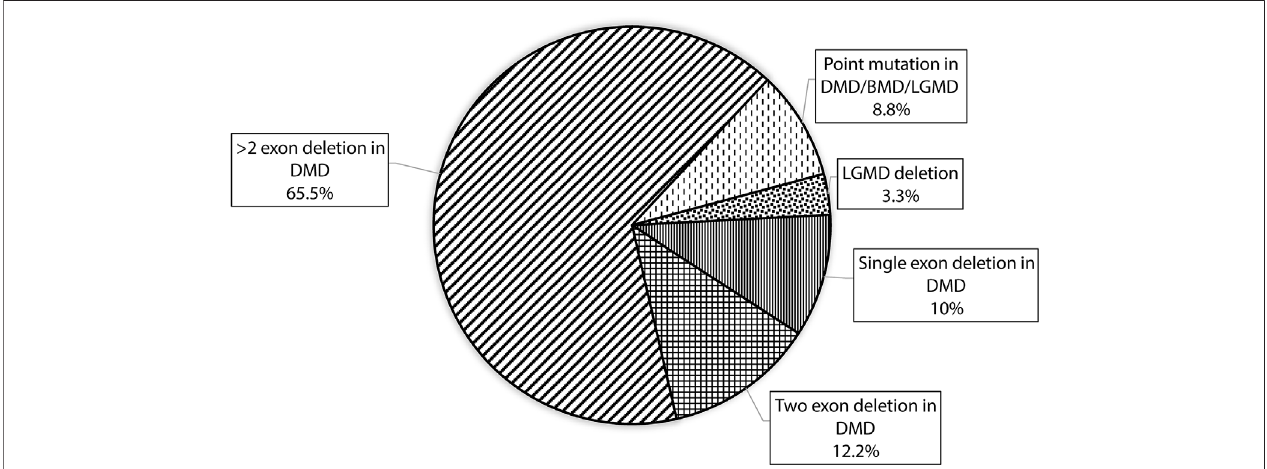
FIGURE 3 | Figure showing the distribution of mutation patterns with designed custom amplicon panel in our study.